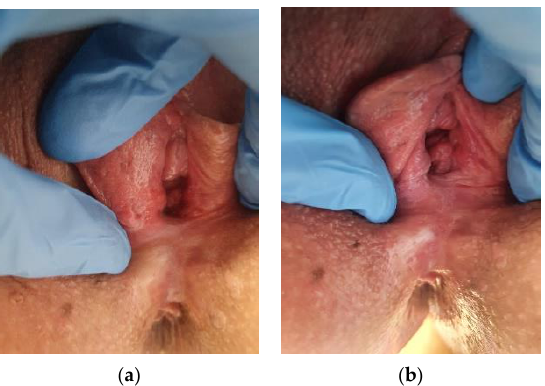
Figure 3. ( a ) Vulvar HSIL appearing as a red lesion; ( b ) after the application of Acetic acid.